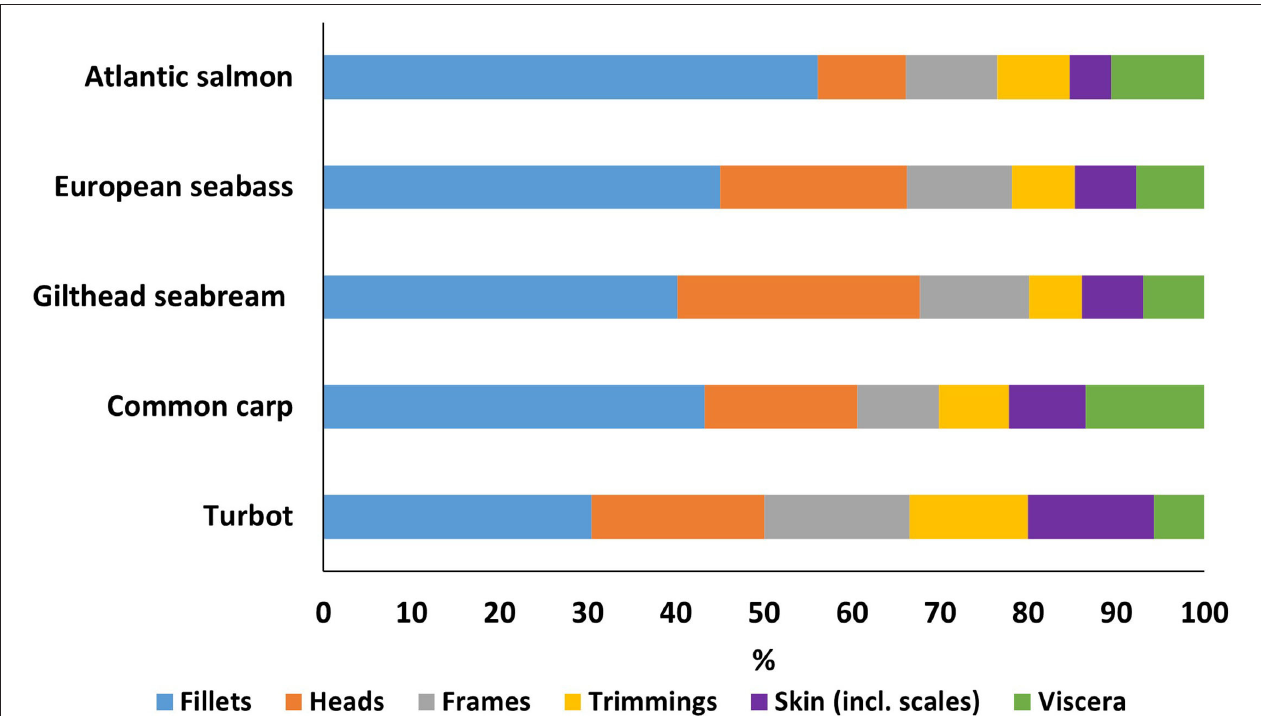
FIGURE 1 | Proportion (%) of different processing fractions for five important European aquaculture